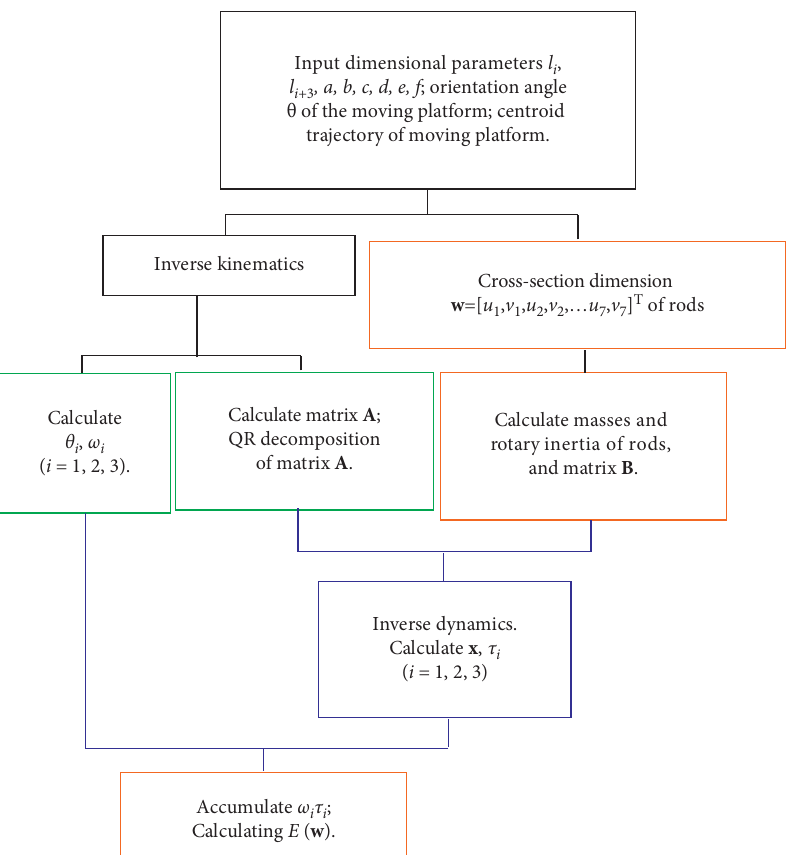
Figure 2: Calculation process of the objective function to determine the optimal cross-sectional dimension of the